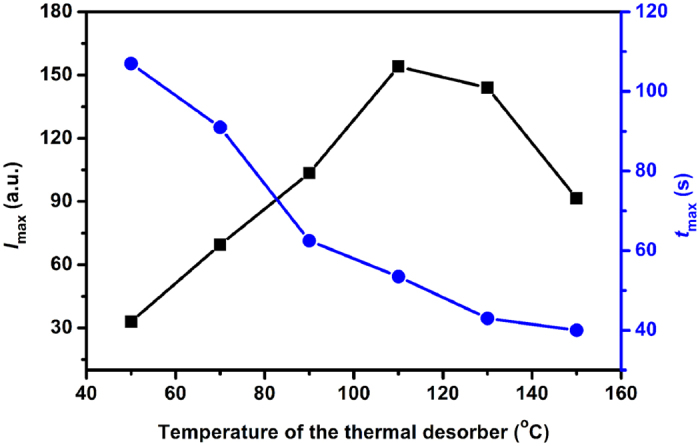
The effect of the thermal desorber temperature on Imax and tmax.